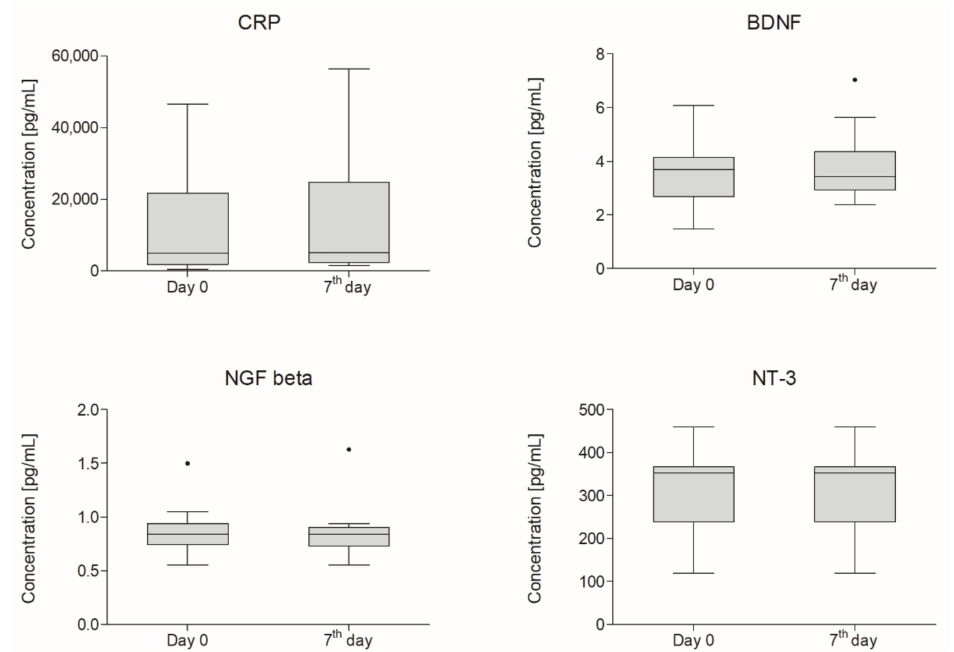
Figure 2. Boxplot of cerebrospinal fluid (CSF) concentrations of analyzed factors (pg / mL) measured on day zero and a week after intrathecal application of lineage-negative cells ( n = 18). Whiskers from 10th to 90th percentile. Horizontal line inside the box indicates the median.